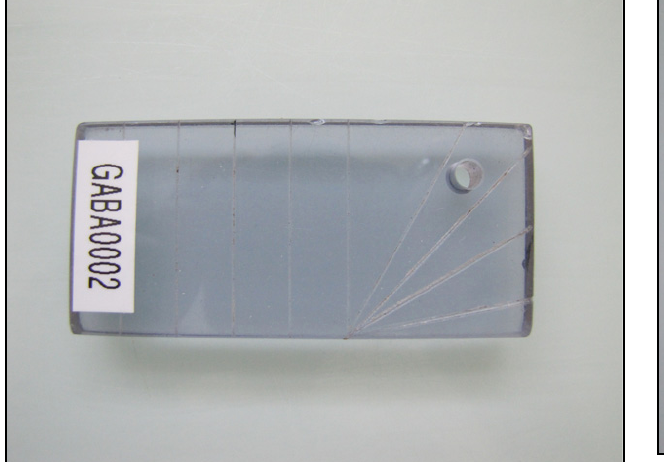
Fig. 4. Examples of orientation of annual ring in sapwood samples.